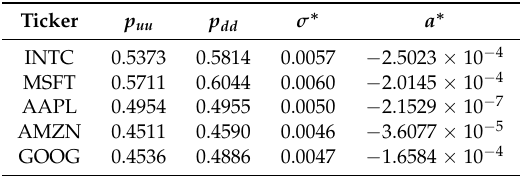
Table 4. Transition matrix and constant parameters for two-state MGCPP. α ∗ and σ ∗ were calculated by Equation